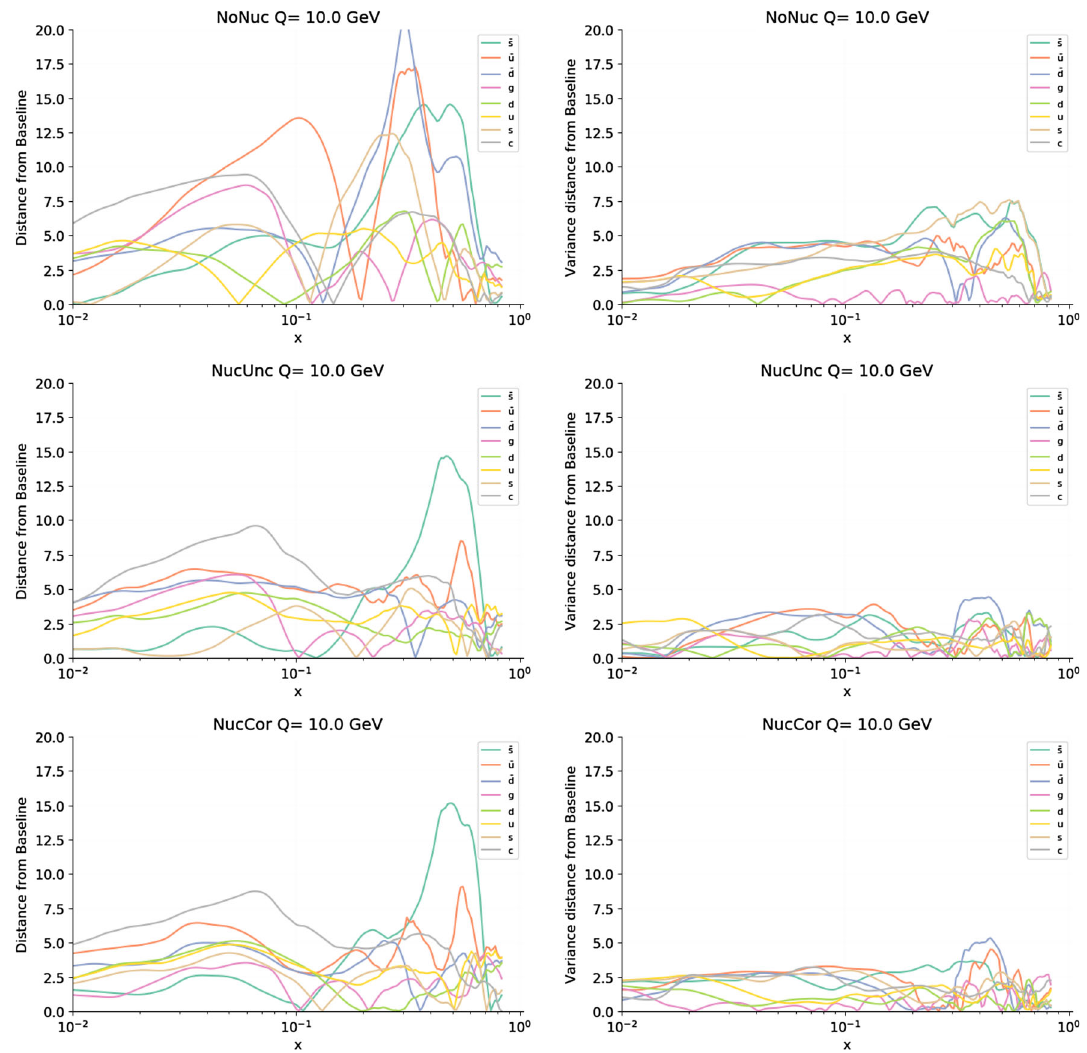
Fig. 9 Distances between the central values (left) and the uncertainties (right) of the Baseline fit and the NoNuc (top), NucUnc (middle), and NucCor (bottom) fits, see text for details. Results are displayed as a function of x at a representative scale of the nuclear dataset, Q = 10 GeV, for all PDF